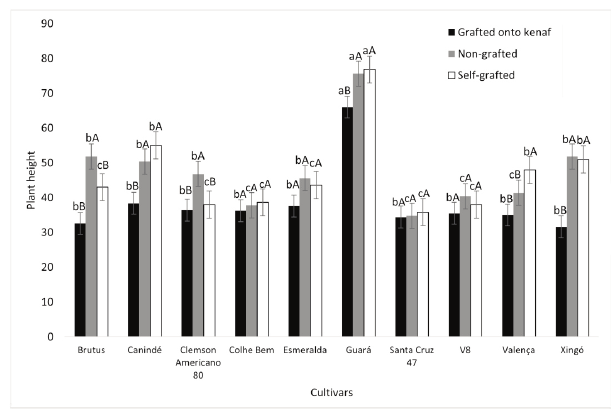
Fig. 3 ­ Interaction between cultivars and seedling production modality for plant height. Means followed by the same uppercase (between seedling production modalities for each cultivar) and lowercase (between cultivars for each seedling production modality) letter do not differ by the Scott­Knott test